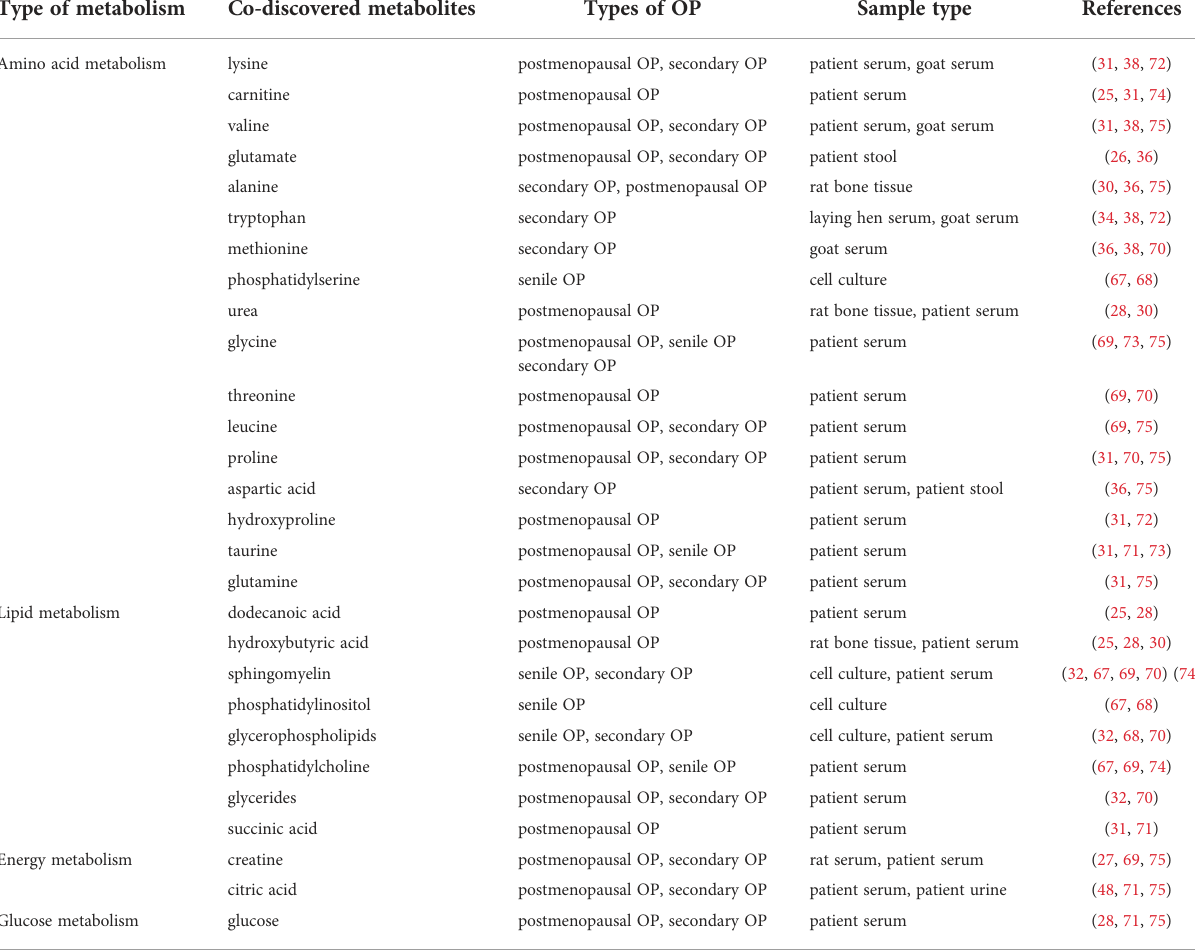
TABLE 2 Metabolomics is used to explore mechanisms of OP, with the same metabolites found in different